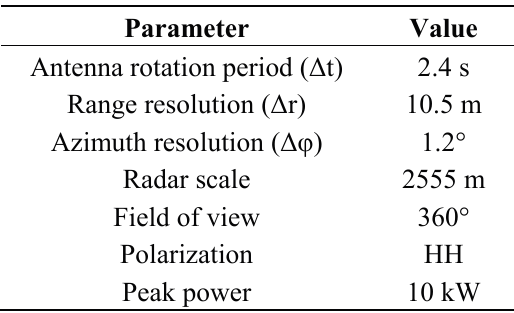
Table 1. Parameters of acquisition